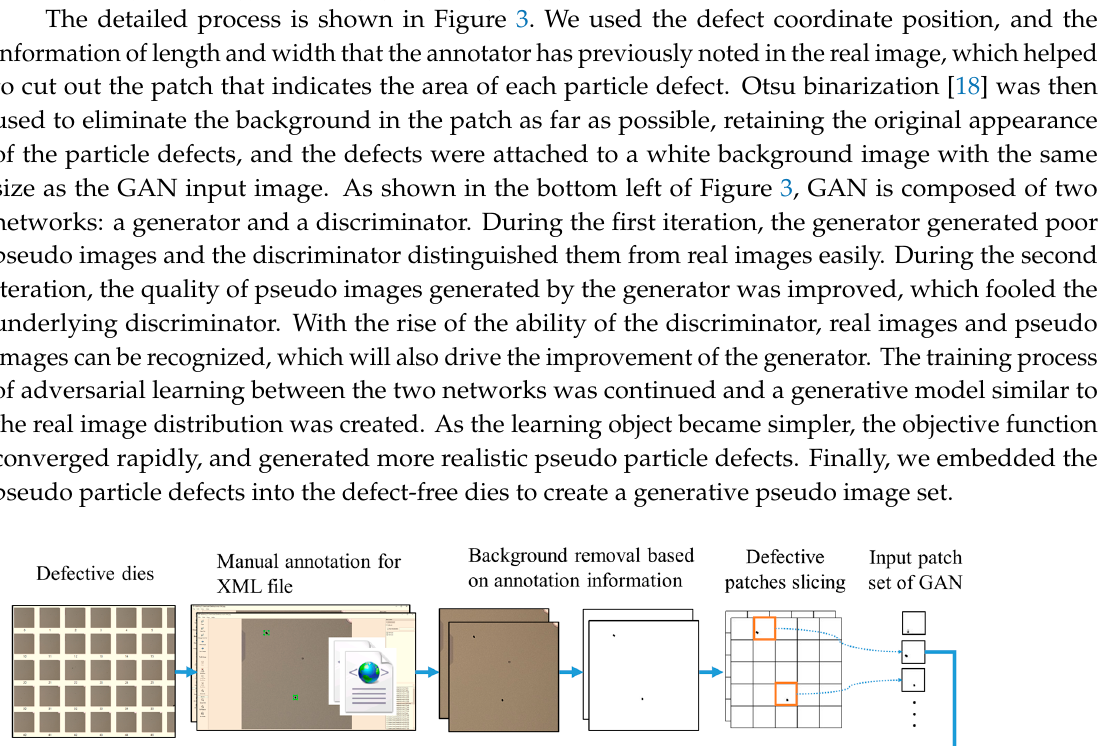
Figure 3. The flowchart of GAN-based data argumentation and auto-annotation. 2.4. Defect Detection and Measurement Using YOLOv3 This research used YOLOv3 [19] as the basis for die defect detection and measurement. The basic idea of YOLOv3 is shown in A.2 of Appendix A. The YOLOv3 model is a one-stage method, end-to- end training process that can be realized using a single network. The inference can predict the center coordinate, width and height of each bounding box where the defect is located, and the confidence that each bounding box contains a defect. After YOLOv3 output the predicted bounding boxes, the study would further measure the defects of the corresponding patches and sort the quality of a die, as shown in Figure 4. The process included Ostu binarization [18], the estimation of the bounding ellipse, and the calculation of the major and the minor axis. The process was able to potentially assist to conduct the sorting of the dies in accordance with the quality specifications of the customers. For example, there were three classes of die products: an excellent die had no particle defect after inspection; a qualified die had particle defects with the major axis length between 50 and 149 μ m and the minor axis length less than 20 μ m; an unqualified die had particle defects that exceeded the quality specification.